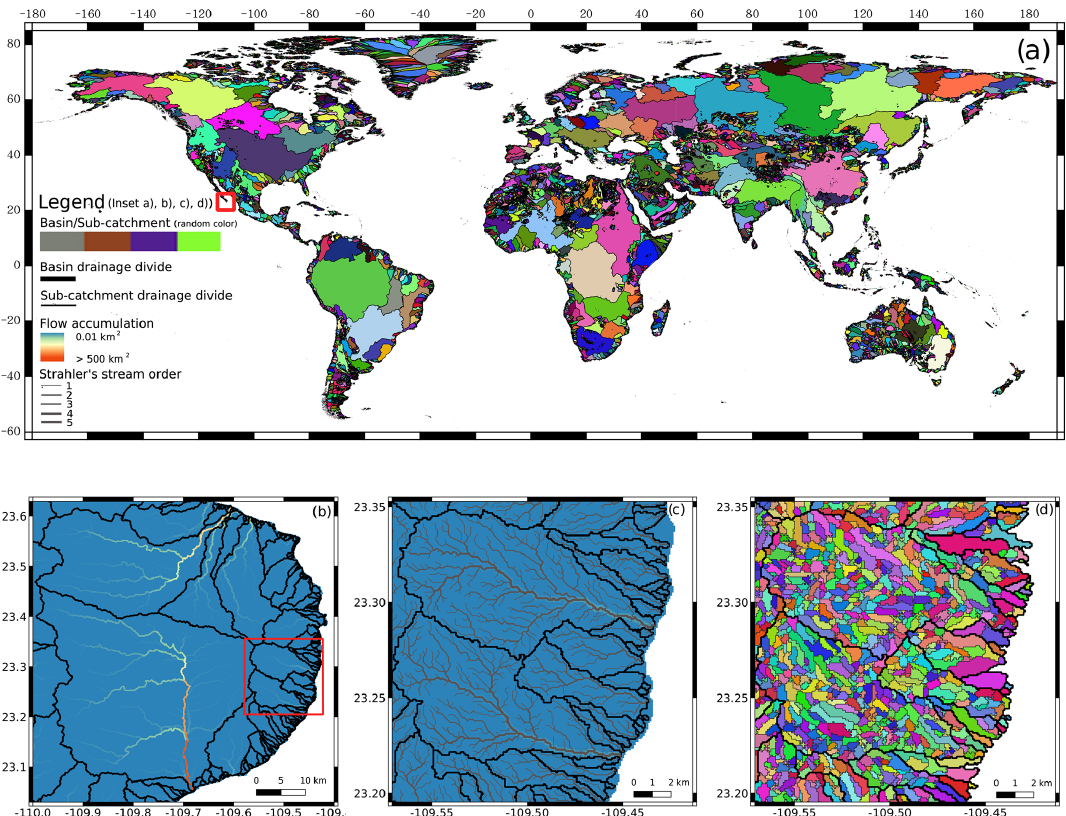
Figure 5. Map (a) shows the global distribution of the newly delineated 1.6 million drainage basins. The red box in Baja California Sur, Mexico, represents the location of inset (b) . This inset shows flow accumulation and the basin drainage divide. Inset (c) shows flow accu- mulation and the stream channel network, where line width corresponds to the Strahler stream order. Map (d) illustrates the corresponding sub-catchments, sharing an identifier ID with stream channels. Drainage basin and sub-catchment colour assignment is random and for illustrative purposes only.